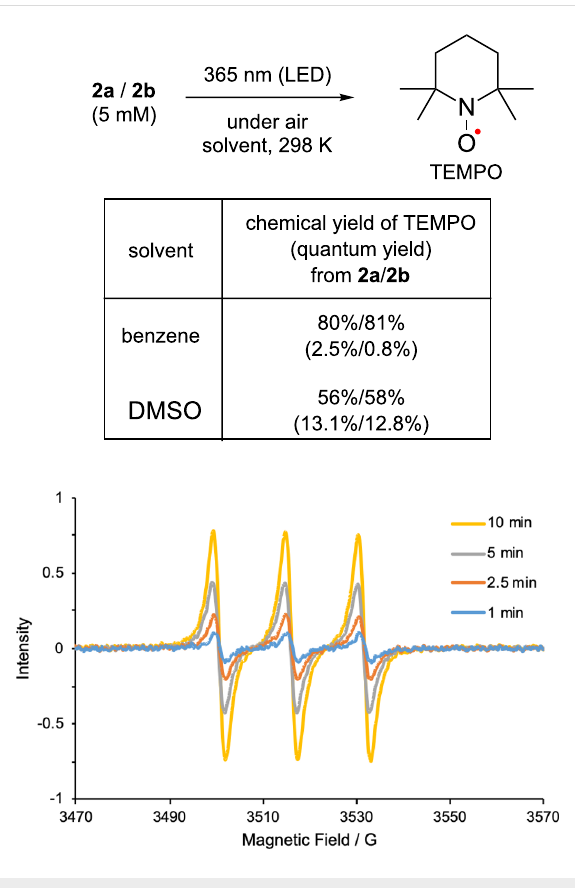
Figure 1: Photochemical generation of TEMPO from 2a and 2b . EPR spectra acquired during the photolysis of 2a (5 mM) in benzene using 365 nm LED light under air atmosphere.